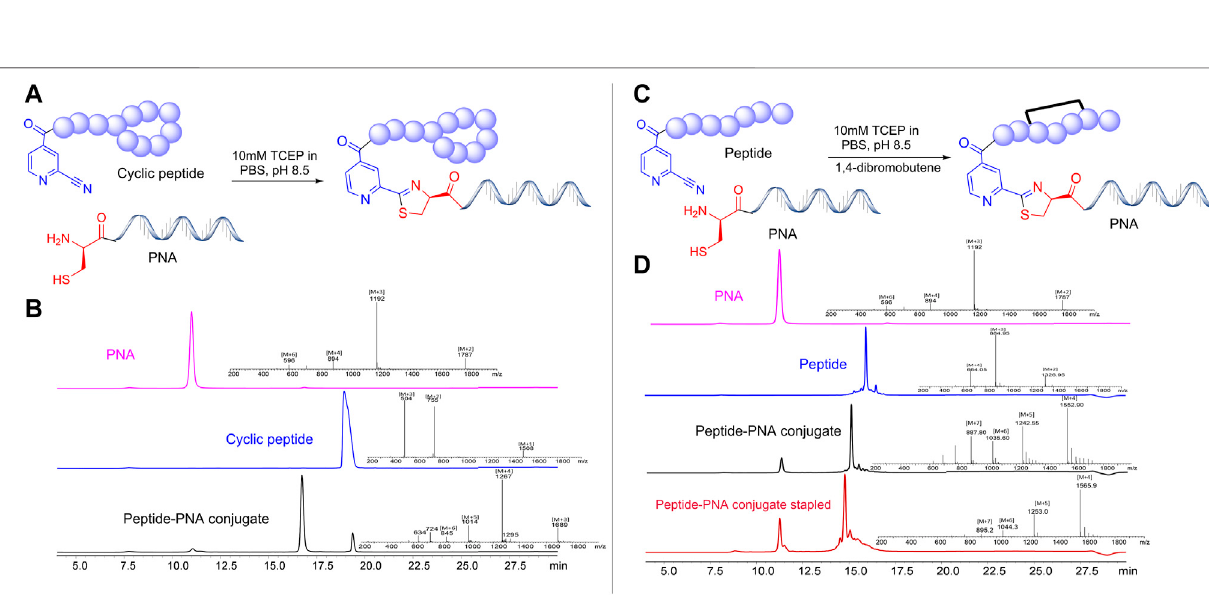
FIGURE 2 | The benzhydryloxyearbonyl (Bhoc) adduct during the Tri fl uoroacetic acid (TFA) cleavage of PNA and optimisation of cleavage protocol.